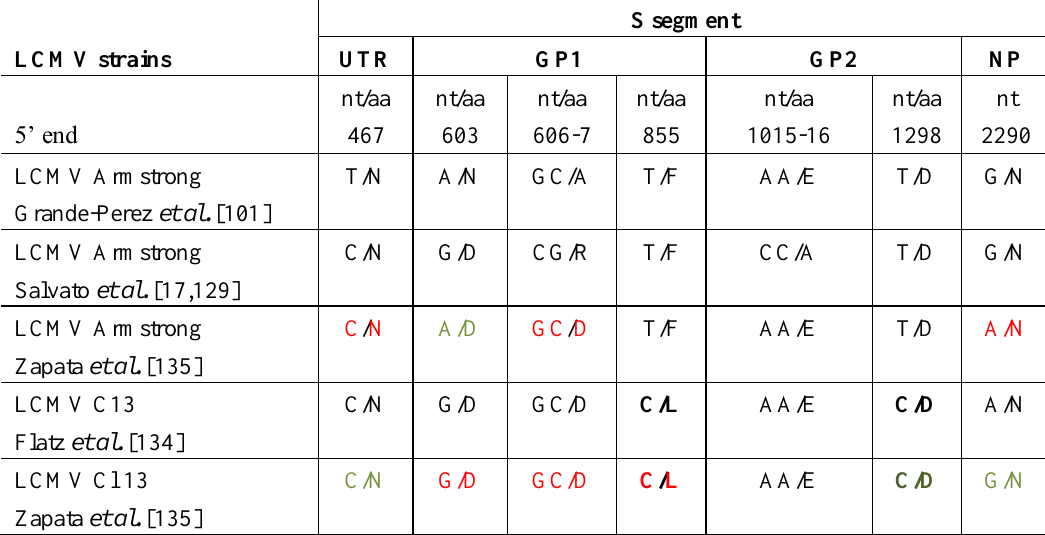
Table 1. LCMV sequence diversity. Comparison between different isolates of LCMV-Armstrong and LCMV-Clone 13. ( A ) Nucleotide and protein single nucleotide polymorphisms (SNPs) from the S segment. ( B ) Nucleotide and protein SNPs from the L segment. Black color letters represent the consensus sequence. Green, blue, and red letters represent abundance of that mutation at nearly 20%, 40% and 100%, respectively. Blue dark squares are the reported differences between both virus strains as follows: In the S segment nucleotide mutation 603 corresponds to amino acid 177, nucleotide mutation 855 corresponds to amino acid 260, nucleotide mutation 1298 corresponds to amino acid 407; in the L segment nucleotide mutation 3797 corresponds to amino acid 1079, nucleotide mutation 1798 corresponds to amino acid 412. The light blue square holds the previously reported mutation and confirmation of its presence in our laboratory strain. The Salvato 2012 pyro-sequencing shows diversity in those viral clones even within the same clone from the same